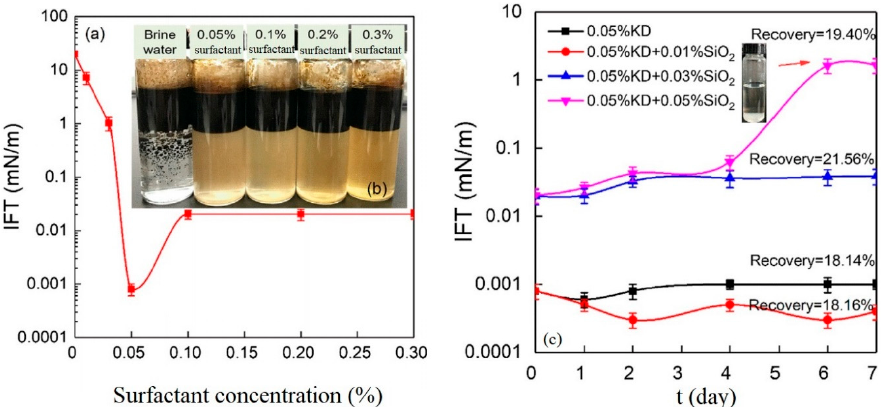
Figure 6. ( a ) IFT between surfactant solutions and oil at 80 ◦ C, ( b ) emulsion stabilization image after 24 h at 80 ◦ C and ( c ) IFT stability of surfactant-based nano-SiO 2 solutions at 80 ◦ C